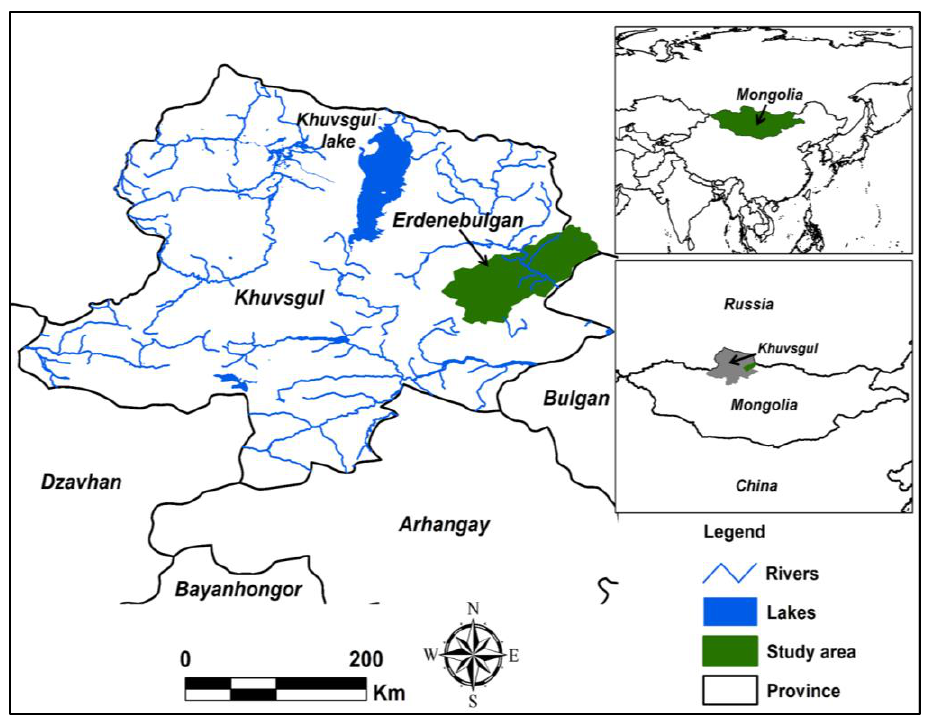
Figure 1. Location map of the study area.